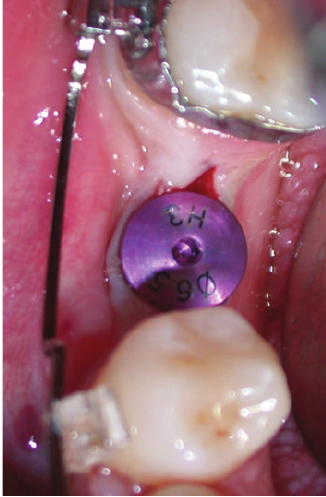
Figure 15: Healing abutment positioning.